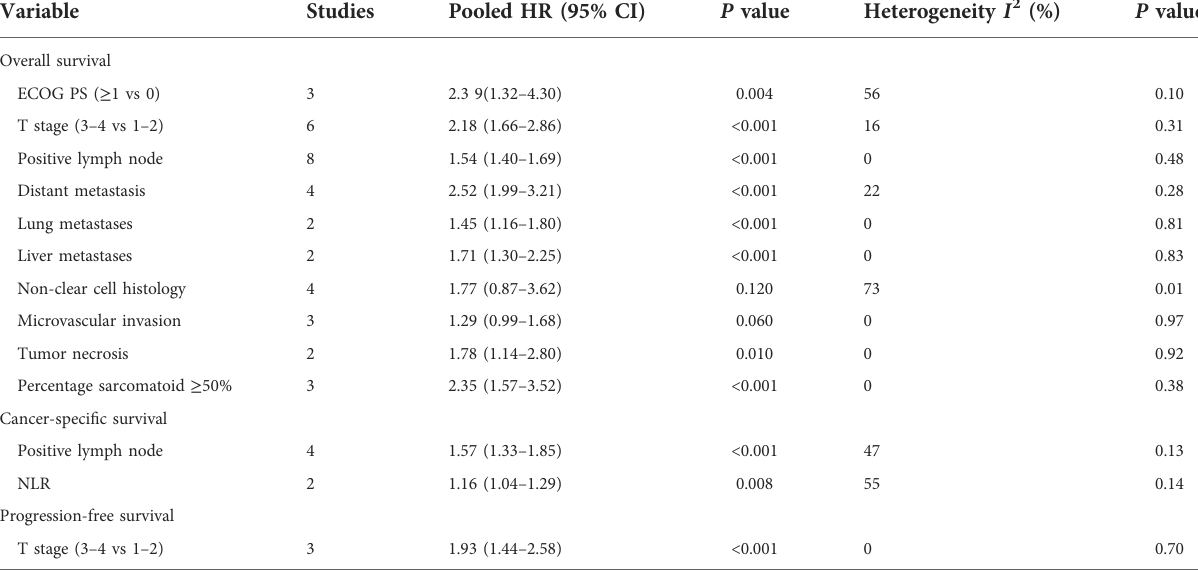
TABLE 2 The pooled results of oncologic outcomes.